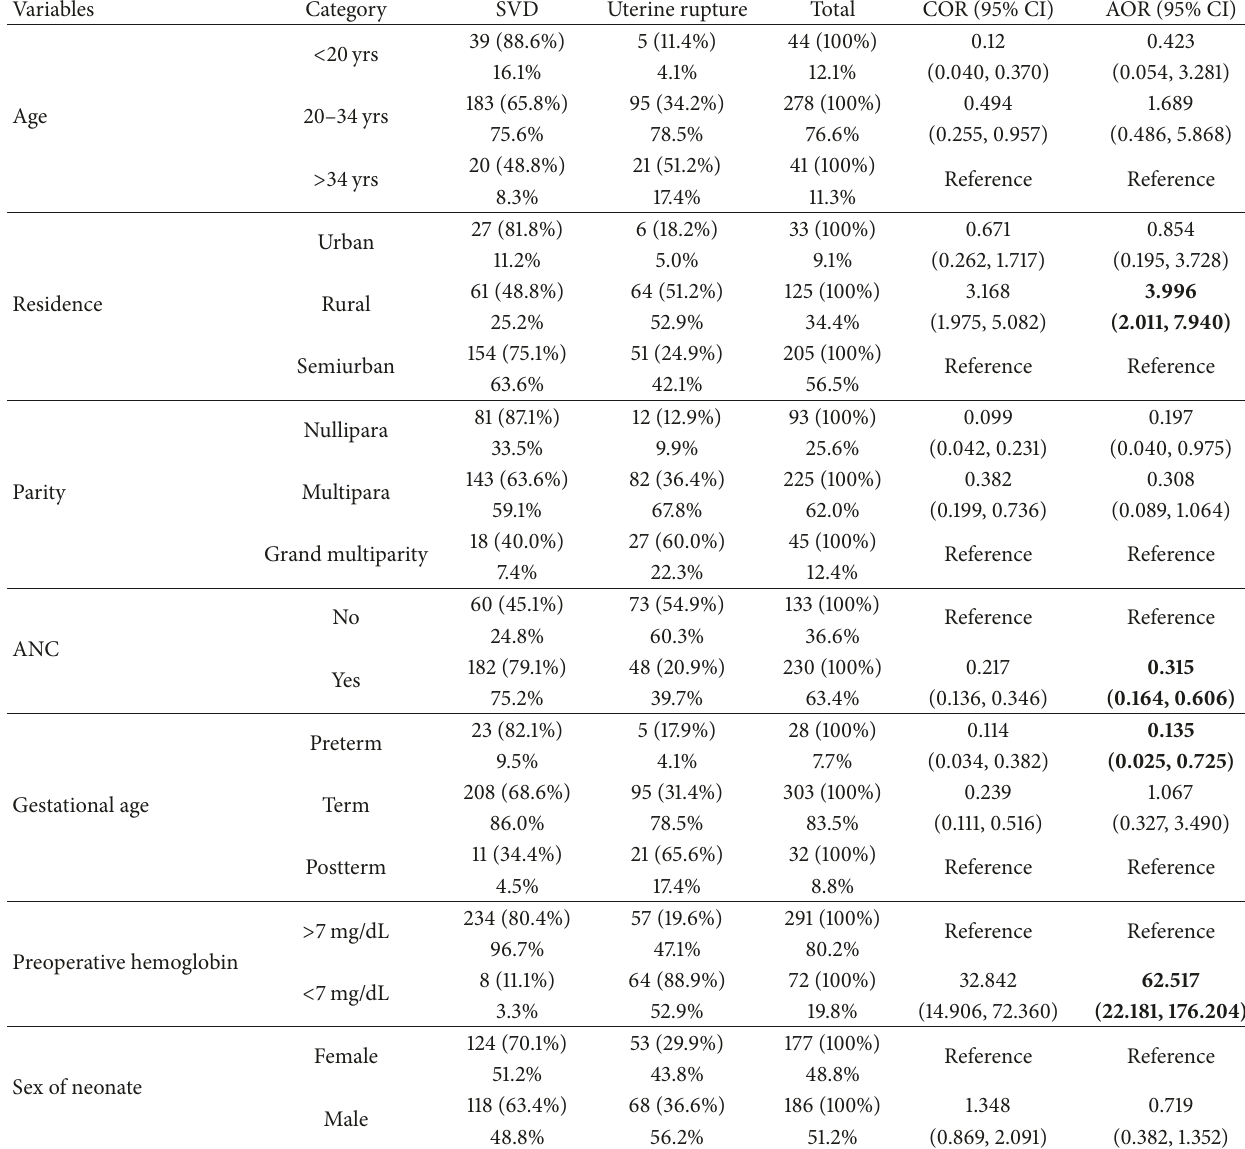
Table 2: Determinant factors of uterine rupture among females who attended maternal health services in MTUTH, MTU,